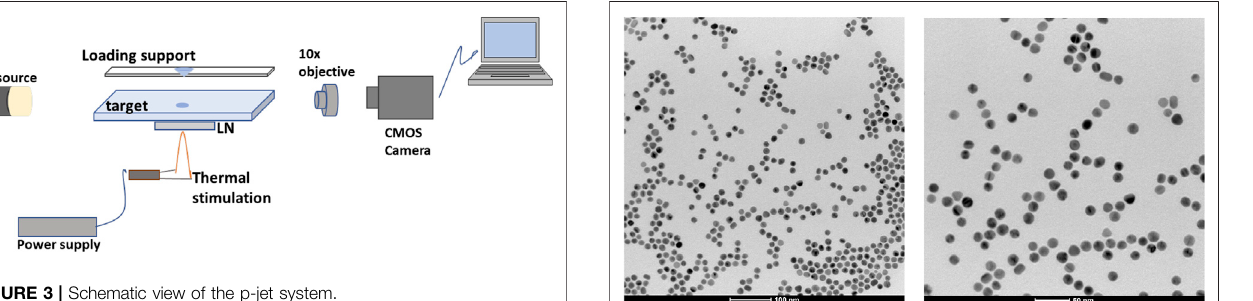
FIGURE 3 | Schematic view of the p-jet